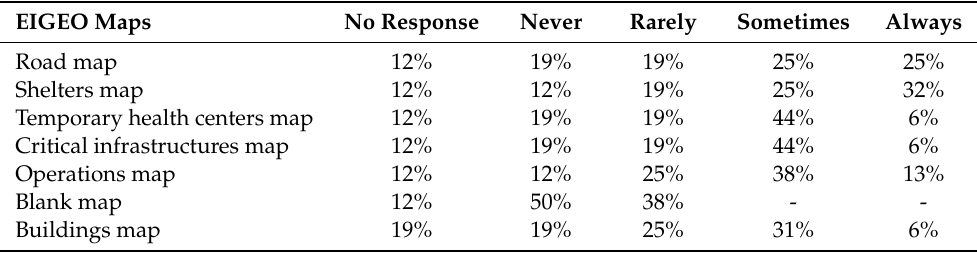
Table 6. Maps generated during EIGEO operations